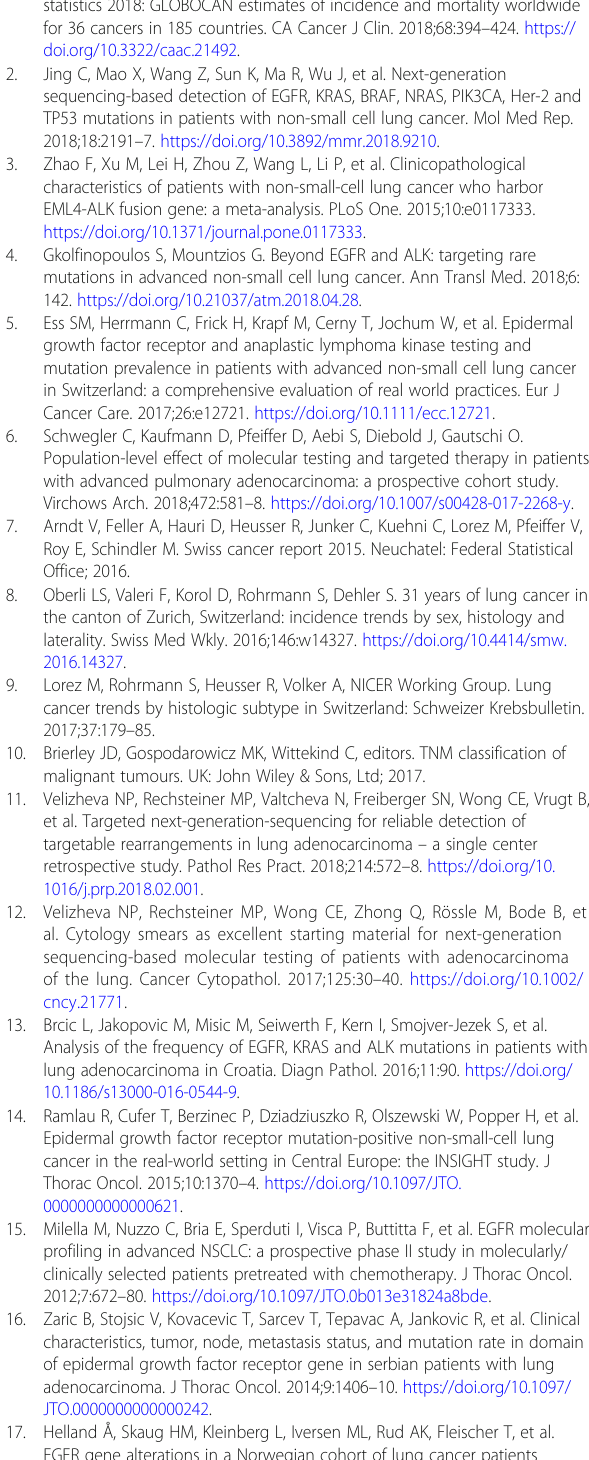
Additional file 1: Table S1. Doublet EGFR mutations in 90 lung cancers. Table S2. Comparison of EGFR and KRAS mutated tumors. Table S3. Comparison of EGFR mutated and ALK rearranged tumors. Table S4. Comparison of KRAS mutated and ALK rearranged tumors. (DOCX 30